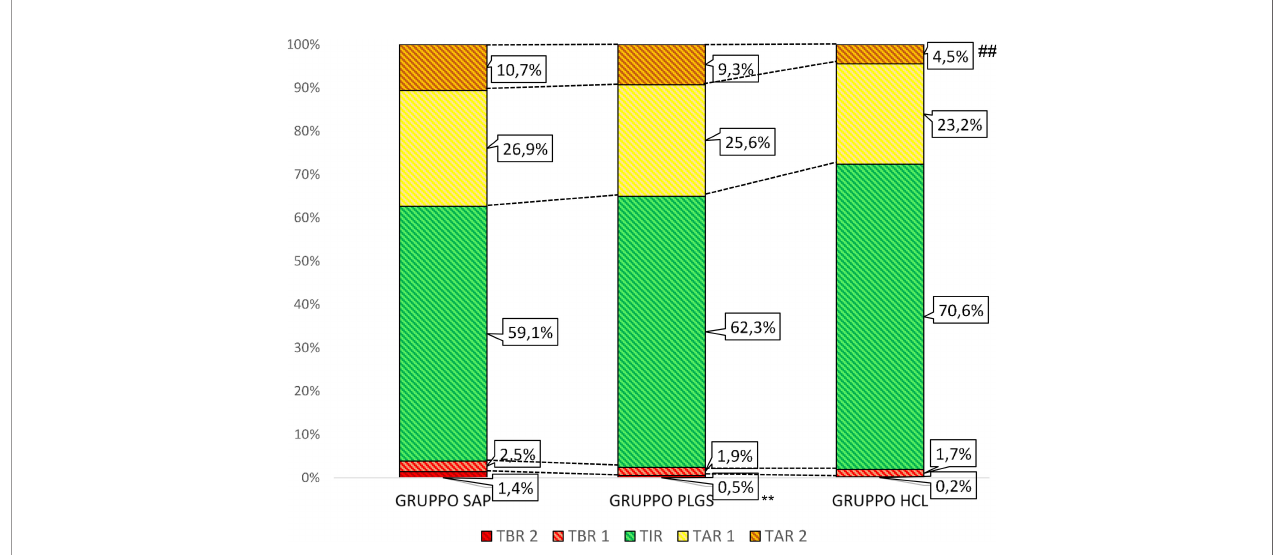
FIGURE 1 | Percentage of time passed in different glycaemia ranges among the three groups of CSII. TAR 1, time above range (181 – 250 mg/dl); TAR 2, time above (>250 mg/dl), TBR 1, time below range (69 – 54 mg/dl); TBR 2, time below range (<54 mg/dl); TIR, time in range (70 – 180 md/dl). ** p values <0.01, HCL group versus PLGS group ## p values <0.01, PLGS group versus SAP group.